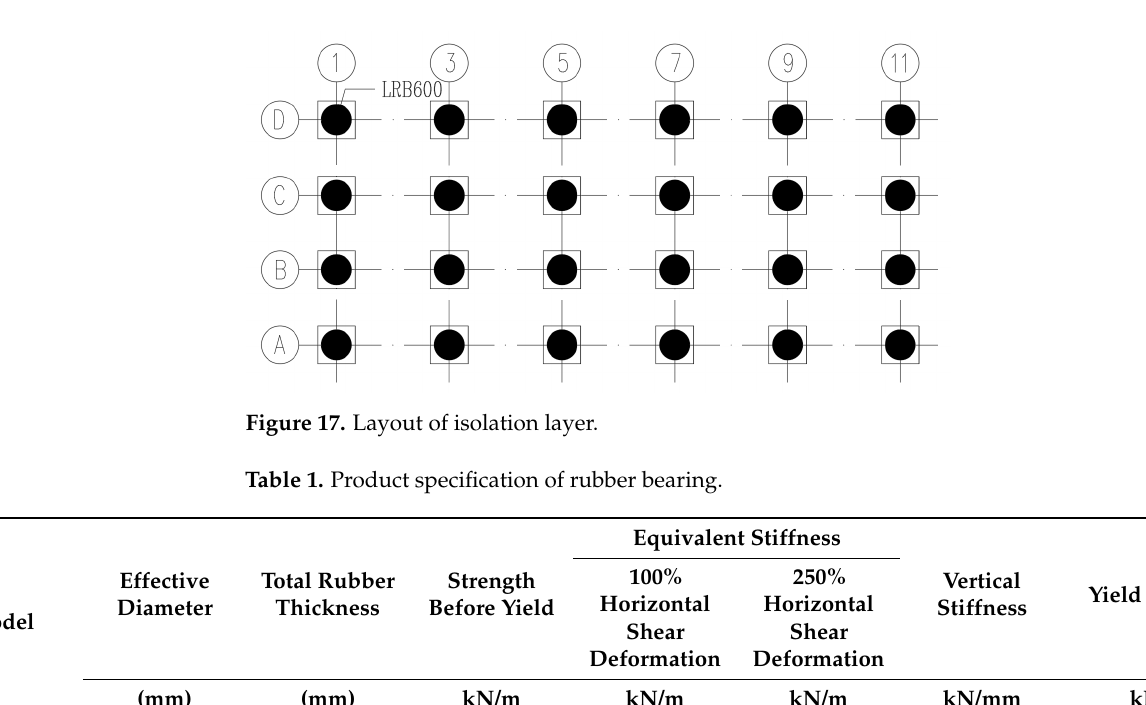
Figure 16. Six-story reinforced-concrete-frame structure model.